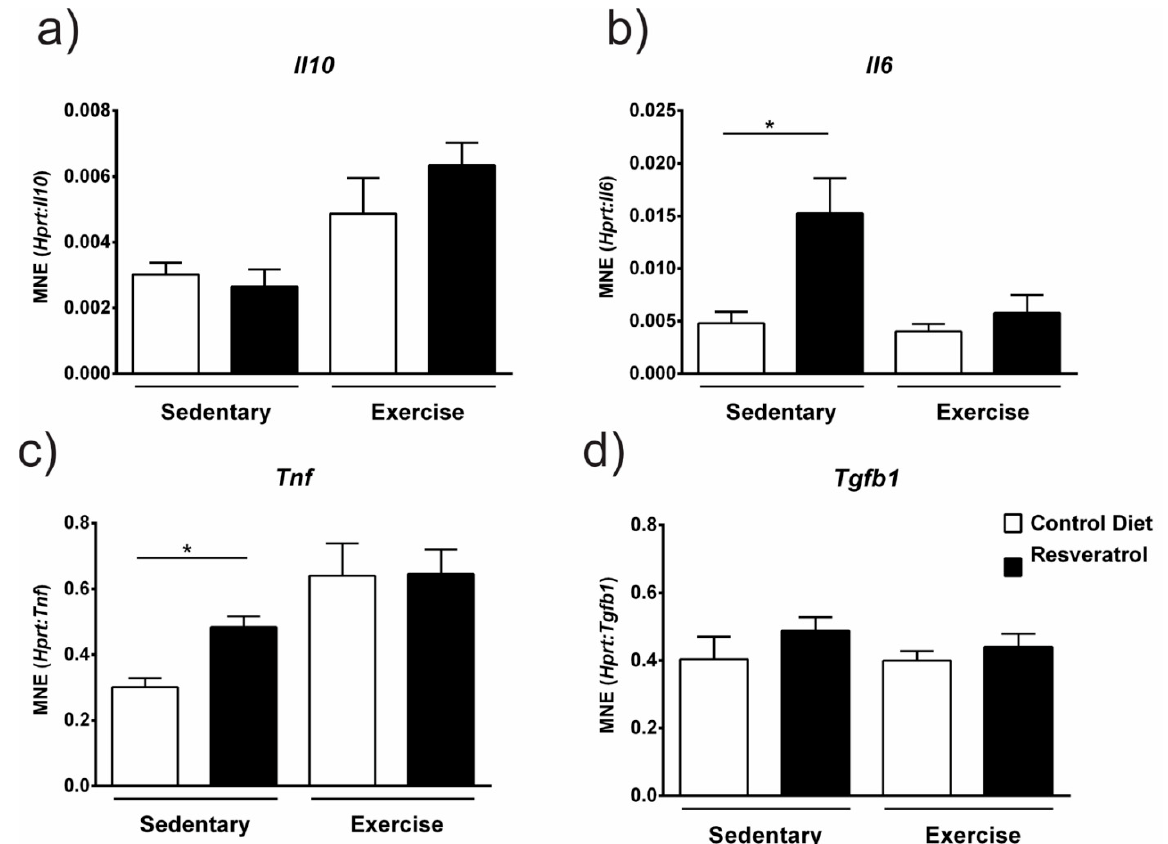
Figure 6. ( a ) Il-10 gene expression is unchanged with resveratrol treatment. ( b ) Il-6 gene expression was up-regulated with resveratrol treatment in the sedentary mdx mice but remained unchanged in the exercised group. ( c ) Gene expression of TNF- α was up-regulated with resveratrol treatment in the sedentary mdx mice, yet remained unchanged in the exercised group. ( d ) Gene expression of Tgf- β was unchanged with resveratrol treatment. There was also no effect of exercise on gene expression of these pro-inflammatory cytokines. Graphs show mean ± SEM. * p < 0.05 ** p < 0.01 n = 5 for each treatment group.